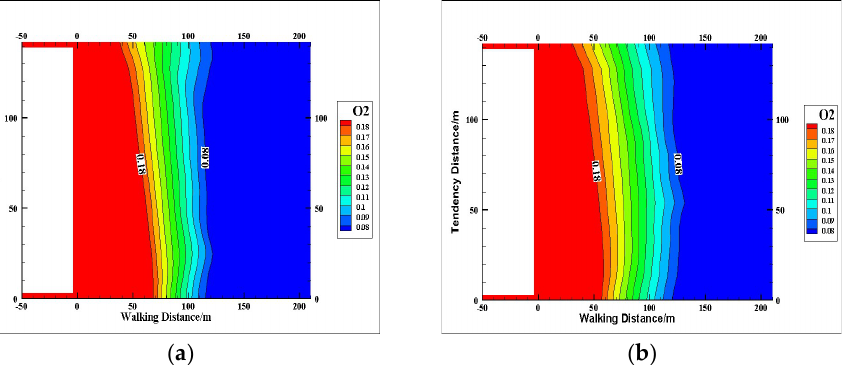
Figure 8. Oxygen concentration distribution in the mining area of stage Ⅴ ~ Ⅵ : ( a ) Stage Ⅴ , ( b ) Stage Ⅵ .